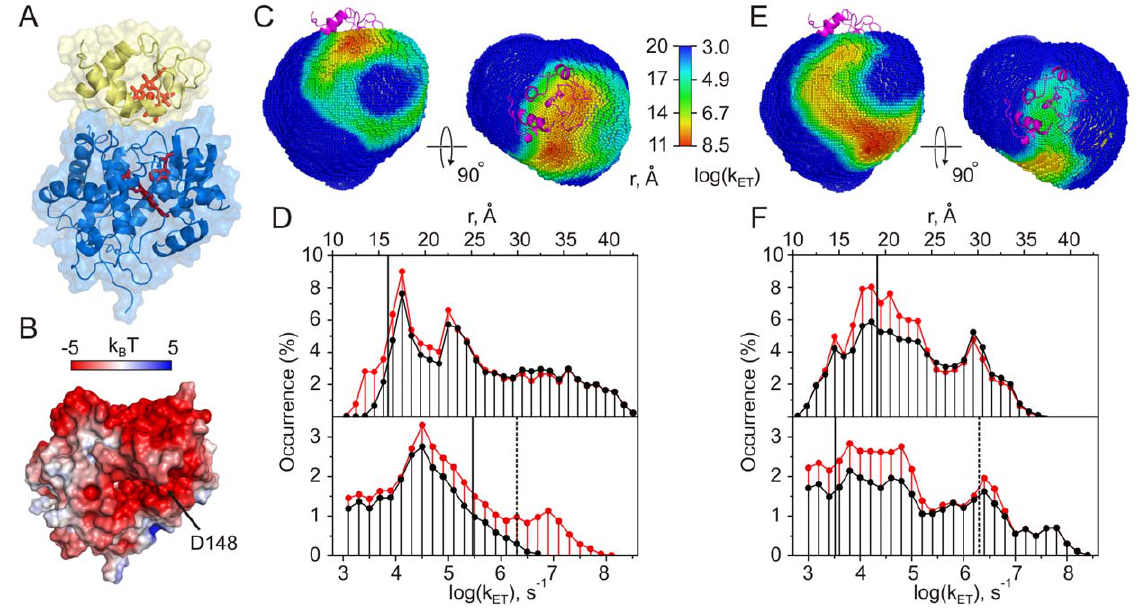
Figure 3. Cc-CcP. (A) Crystal structure of the complex [37]. Cc and CcP are in yellow and blue, respectively; heme groups and CcP residue W191 are shown as red sticks. (B) The molecular surface of CcP colored by the electrostatic potential (see the scale bar) calculated with APBS [68]. Low-affinity binding site is located around CcP residue D148, indicated by the arrow. Protein orientation is the same as in (A). (C), (E) Distributions of Cc centers of mass (CM) around CcP colored by the heme-W191 (C) or heme-heme (E) distances and the corresponding ET rates (see the scale bar). The left view is in the same orientation as in (A). The right view is obtained by rotation around the horizontal axis as indicated. Cc in the crystallographic orientation is shown as magenta cartoon. See Supplementary Videos S1 and S2 for an expanded view of (C) and (E), respectively. (D), (F) Distributions of the intermolecular heme-W191 (D) or heme-heme (F) distances (top) and the corresponding ET rates (bottom). Red and black traces are the distributions for the binary and ternary complexes, respectively. Solid vertical lines indicate the heme-W191 (D) or heme-heme (F) distance in the X-ray structure of the complex (top) and the corresponding ET rates (bottom). Dashed lines denote the largest experimentally measured ET rate in the Cc-CcP complex [41]. All molecular graphics were prepared with PyMOL [69].